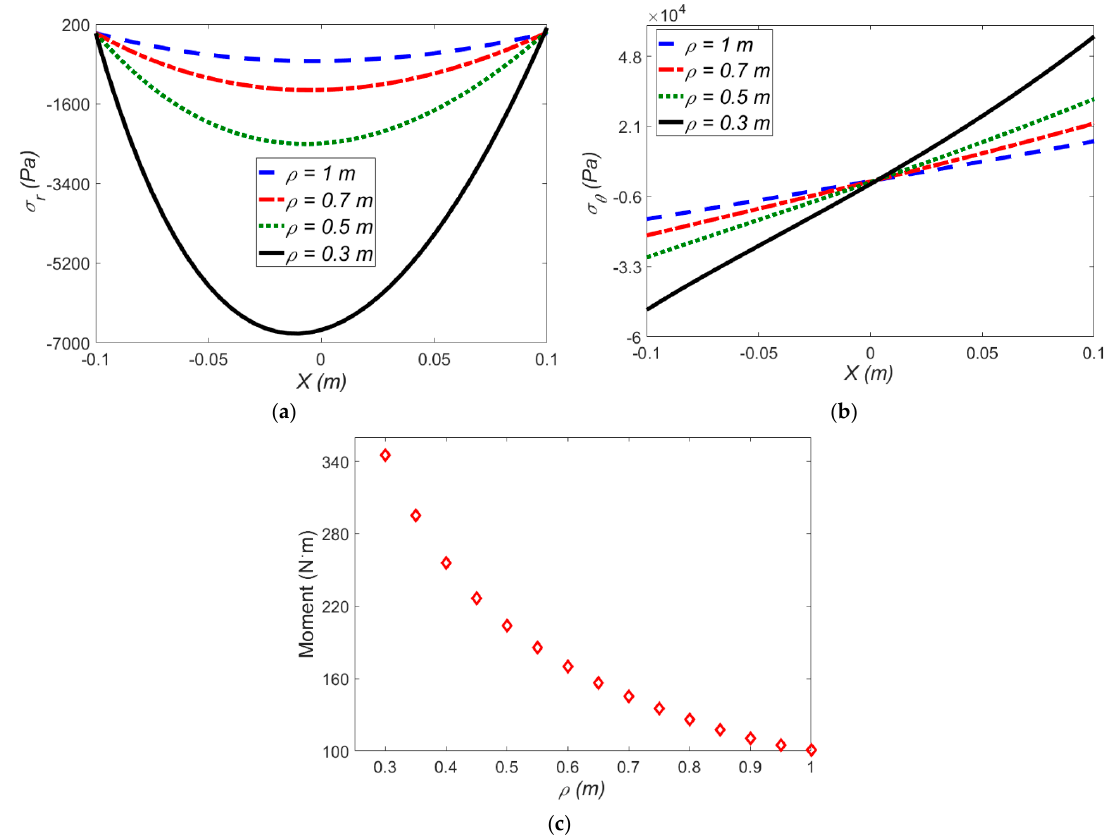
Figure 7. The effect of applied mean radius of curvature on ( a ) radial stress; ( b ) hoop stress; ( c ) induced moment for the exp-exp model at E 1 = 20 MV·m − 1 and Δ T = 0 °C.